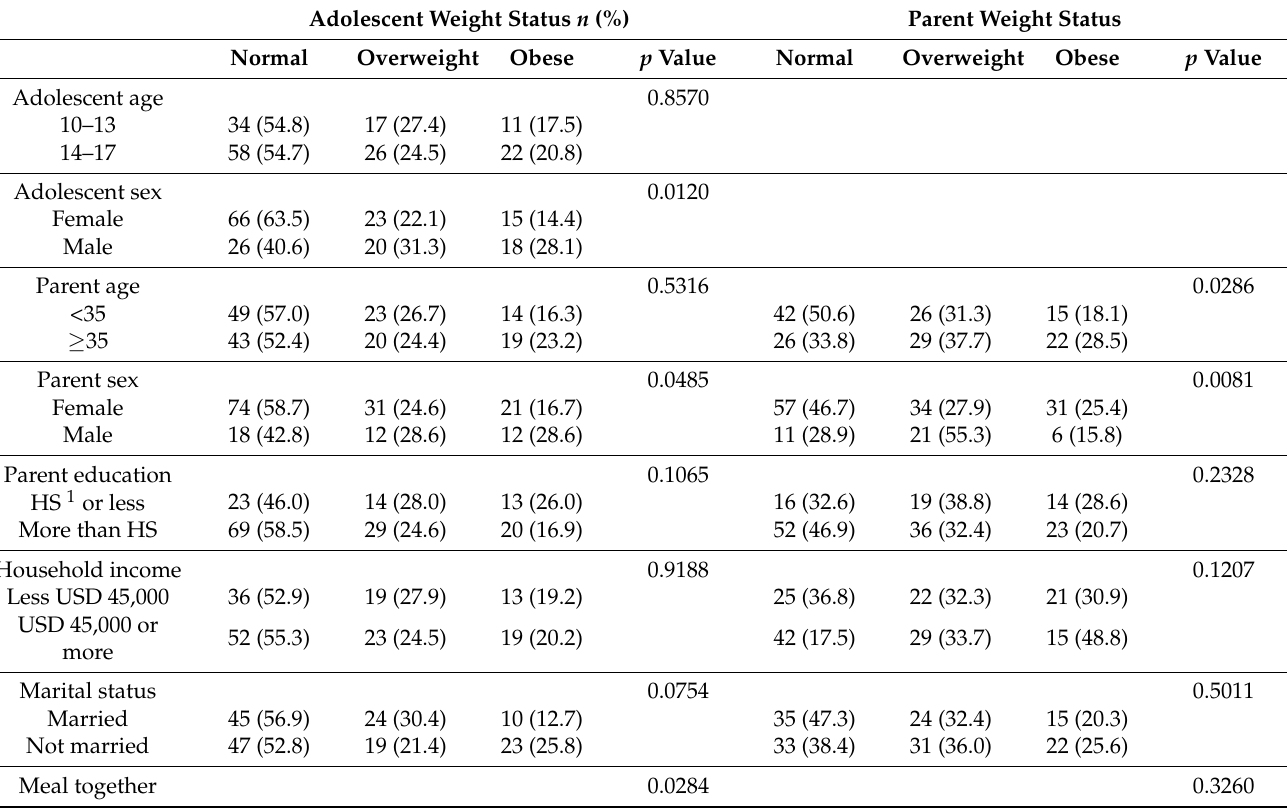
Table 5. Correlation between different demographic data and weigh status of both adolescents and